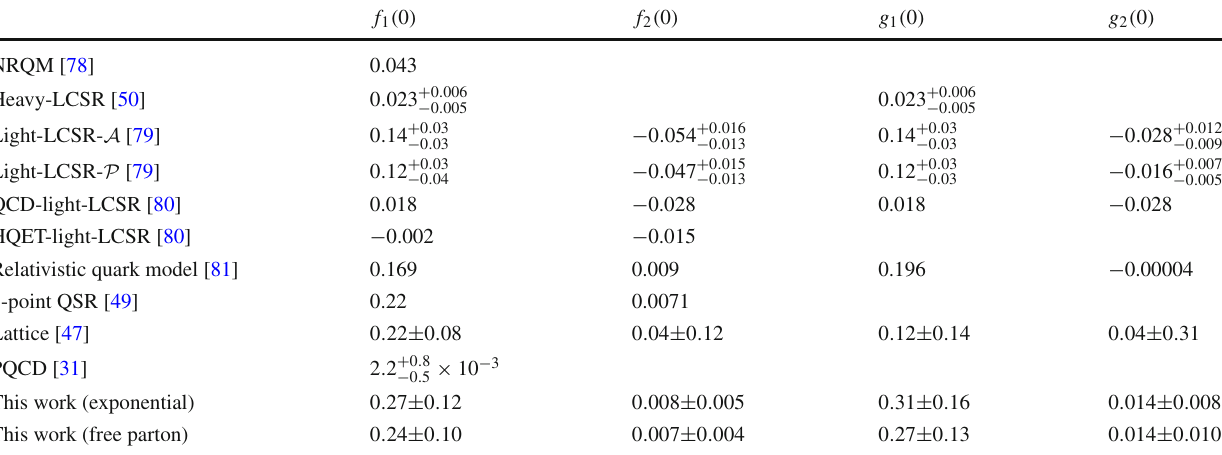
Table 6 Form factors f 1 ( 0 ) , f 2 ( 0 ) , g 1 ( 0 ) and g 2 ( 0 ) from the expo- nential and free-parton models of the (cid:2) b baryon LCDAs obtained in this work and in the NRQM, LCSR, 3-point QSR, lattice and previous